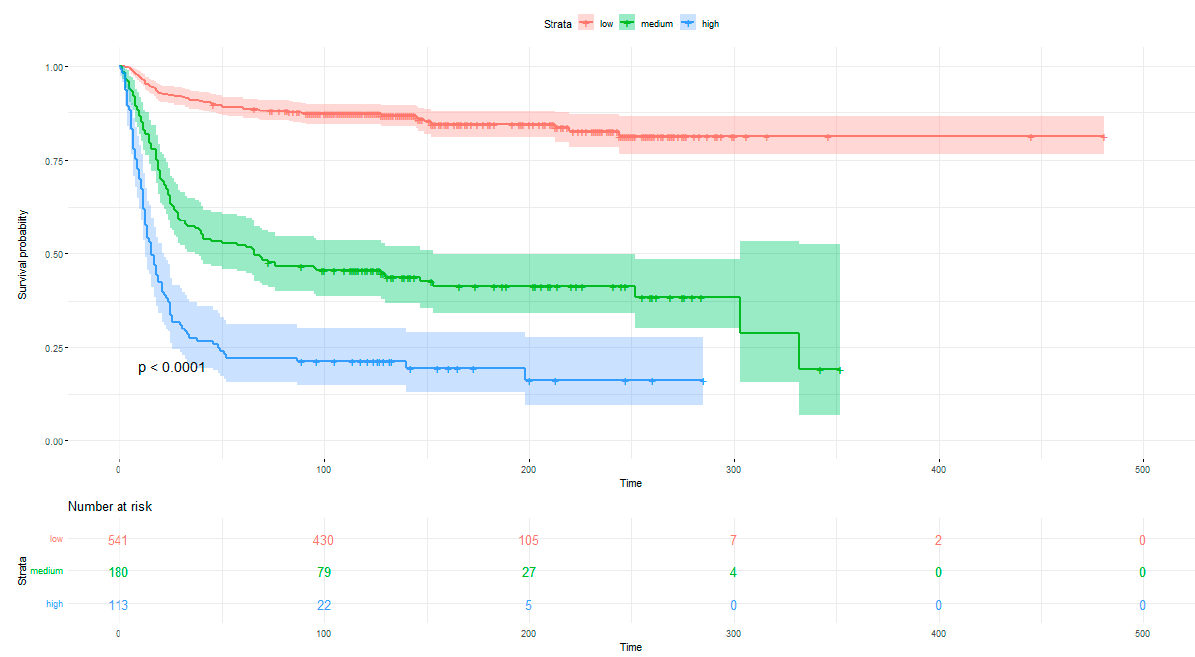
Figure 5. In-hospital survival probability analysis for low-, medium- and high-risk patients with COVID-19 using the COVID-GRAM score.